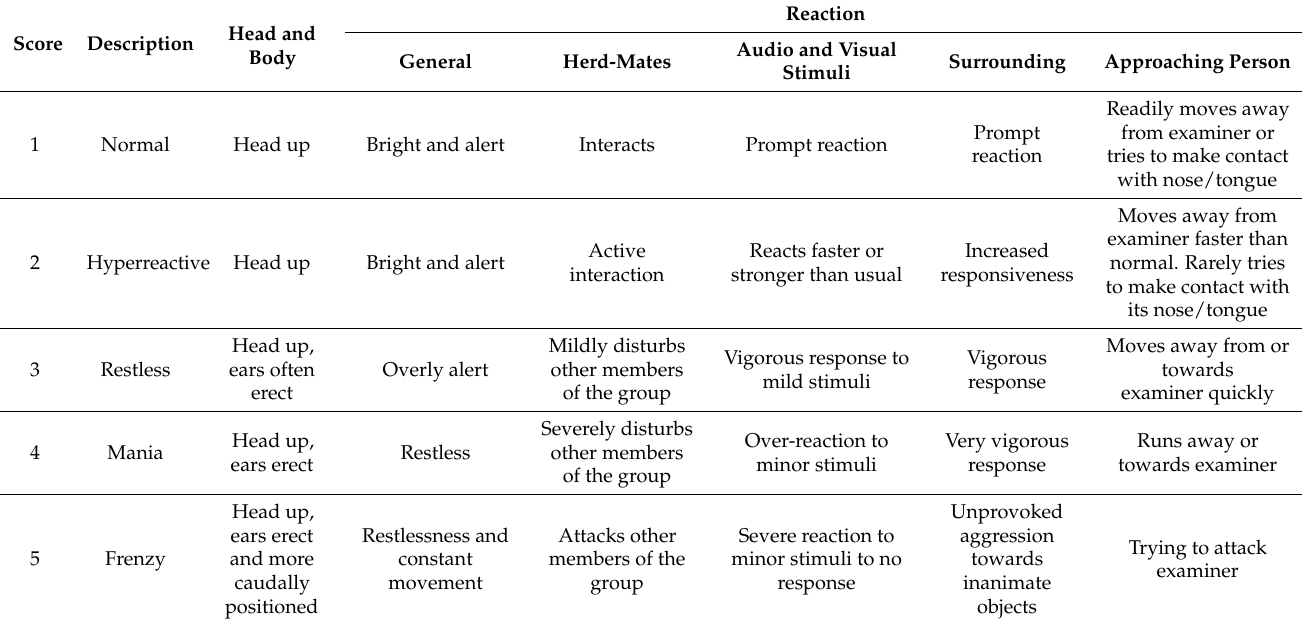
Table 2. Scoring of hyperexcitability in